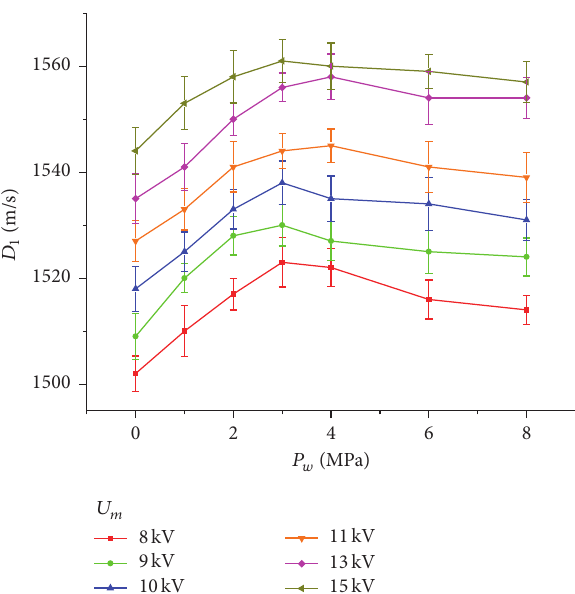
Figure 11: Incident shock wave velocity ( 𝐷 1 ) at 2.5 m from the electrode.